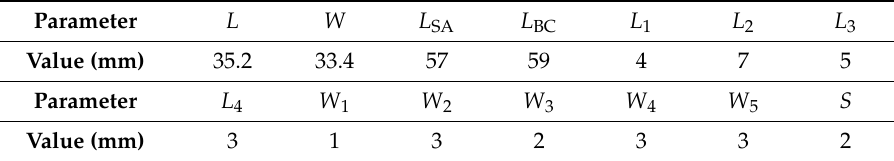
Table 3. Final parameters of the proposed antenna.